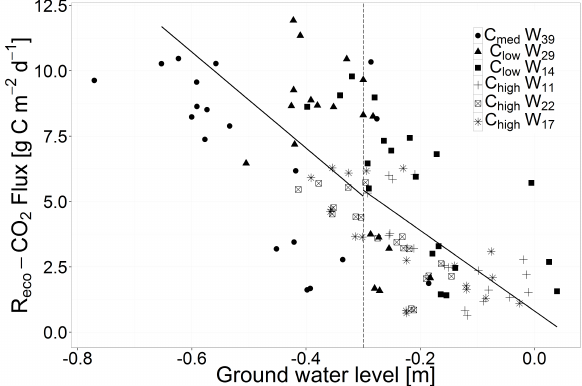
Fig. 5. Ground water levels [m] vs. R eco -CO 2 Flux [gCm − 2 d − 1 ] on the campaign dates for all six sites. Dotted vertical line: border of peat horizon; continuous line: population mean prediction from the linear mixed effects model for all sites; a fixed effect was used to distinguish water levels below the peat horizon ( − 0.8 to − 0.3m) and within the peat horizon ( − 0.3 to +